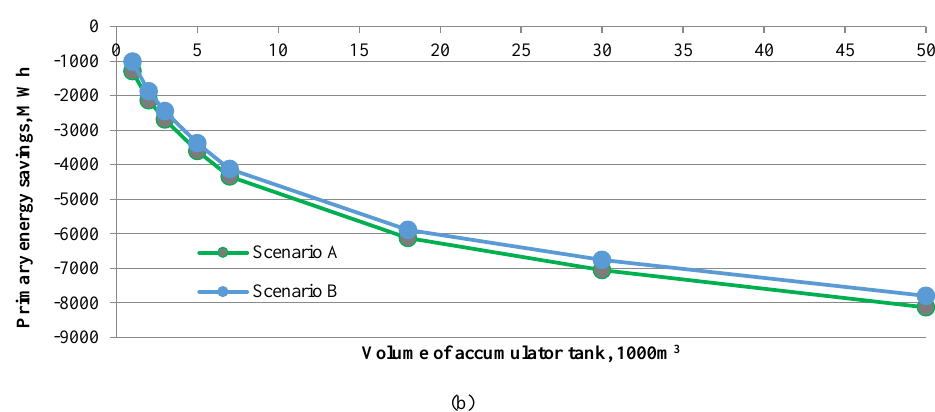
Fig. 8. Environmental indicators: (a) primary energy savings based on heat storage size; (b) CO 2 emission savings, based on heat storage